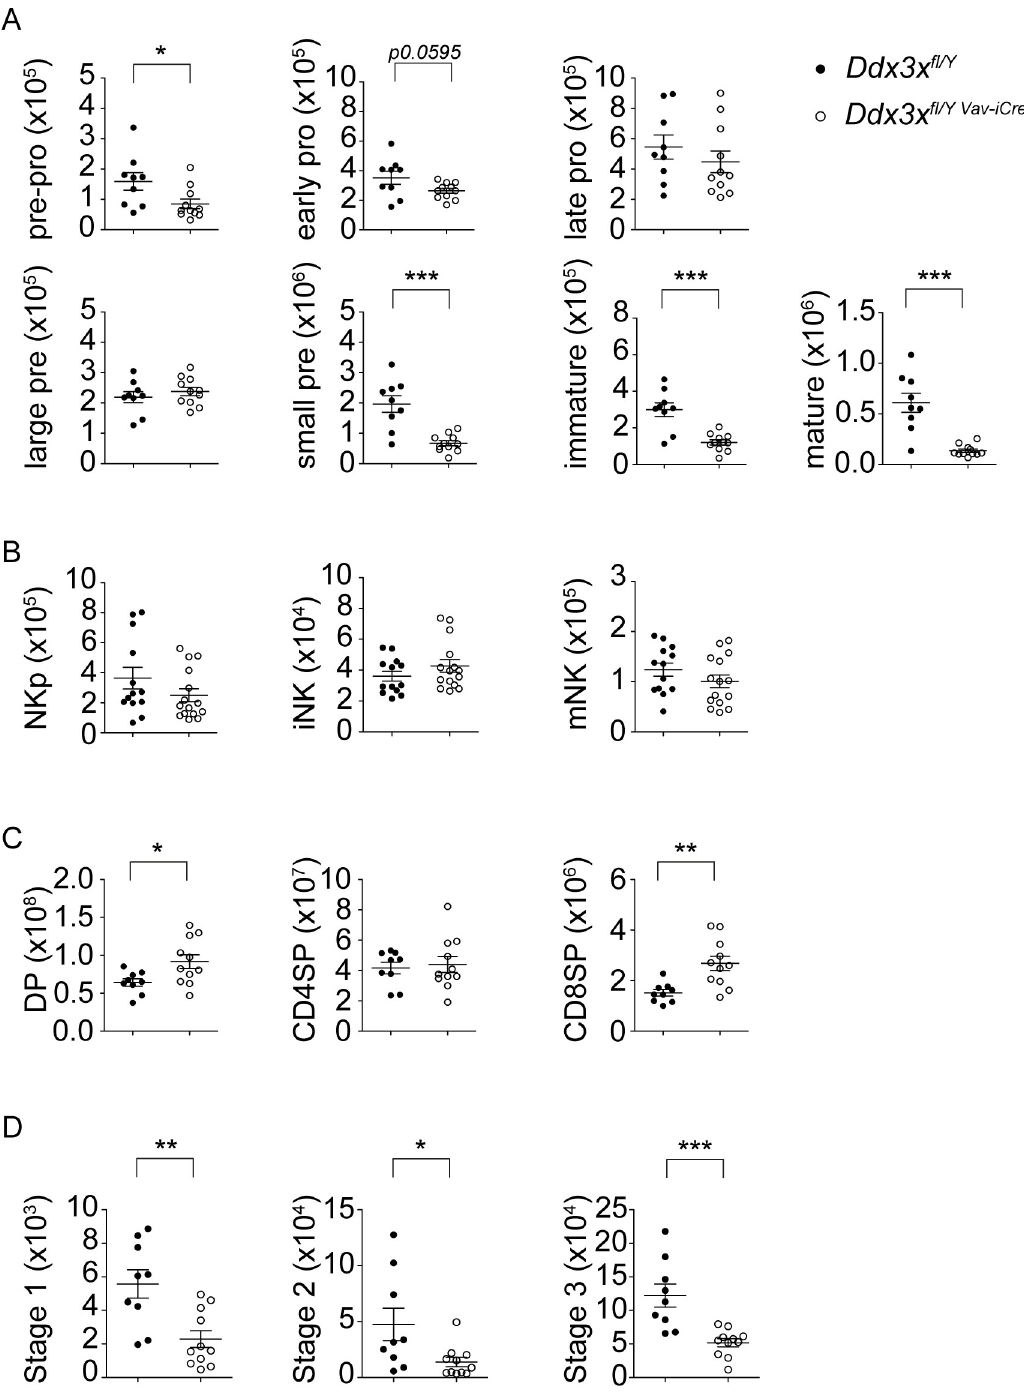
Fig 4. Loss of DDX3X affects hematopoiesis. A Bone marrow cells were isolated from uninfected Ddx3x fl/y and Ddx3x fl/y Vav-iCre mice and stained for B220, CD43, BP1, CD24 and IgM. Total cell numbers (referring to one femur and one tibia) of CD43 + B220 + CD24 - BP1 - pre-pro B cells, CD43 + B220 + CD24 + BP1 - early pro B cells, CD43 + B220 + CD24 lo BP1 + late pro B cells, CD43 + B220 + CD24 hi BP1 + large pre B cells, CD43 - B220 + small pre B cells, B220 lo IgM + immature B cells and B220 hi IgM + mature B cells are shown (n = 9 for Ddx3x fl/y and 11 for Ddx3x fl/y Vav-iCre mice, analyzed in 2 independent experiments). B Bone marrow cells were isolated from uninfected Ddx3x fl/y and Ddx3x fl/y Vav-iCre mice and stained with a lineage mix (consisting of Gr1, Ter119, B220 and CD3) and antibodies against CD122, NK1.1 and Dx5. Total cell numbers (referring to one femur and one tibia) of lineage - CD122 + NK1.1 - Dx5 - NK progenitors (NKp), lineage - CD122 + NK1.1 + immature NK cells (iNK) and lineage - CD122 + NK1.1